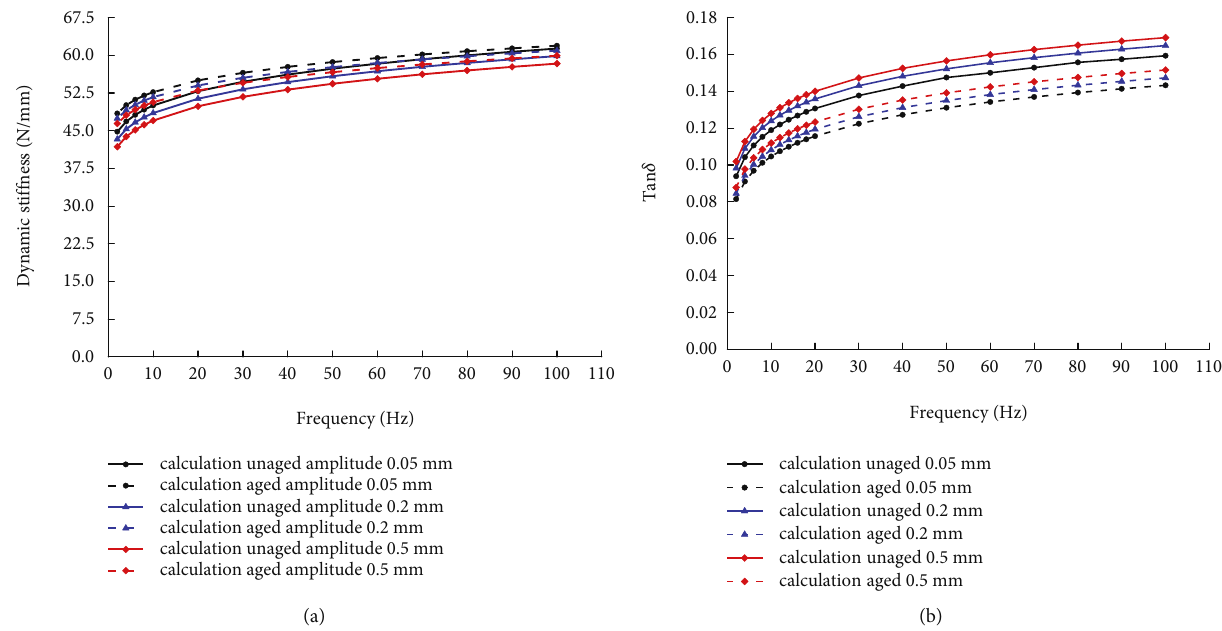
Figure 18: Calculation values of the dynamic sti ff ness and the loss factor of the RIP at the di ff erent amplitudes. (a) Calculation values of the dynamic sti ff ness and (b) calculation values of the loss factor.